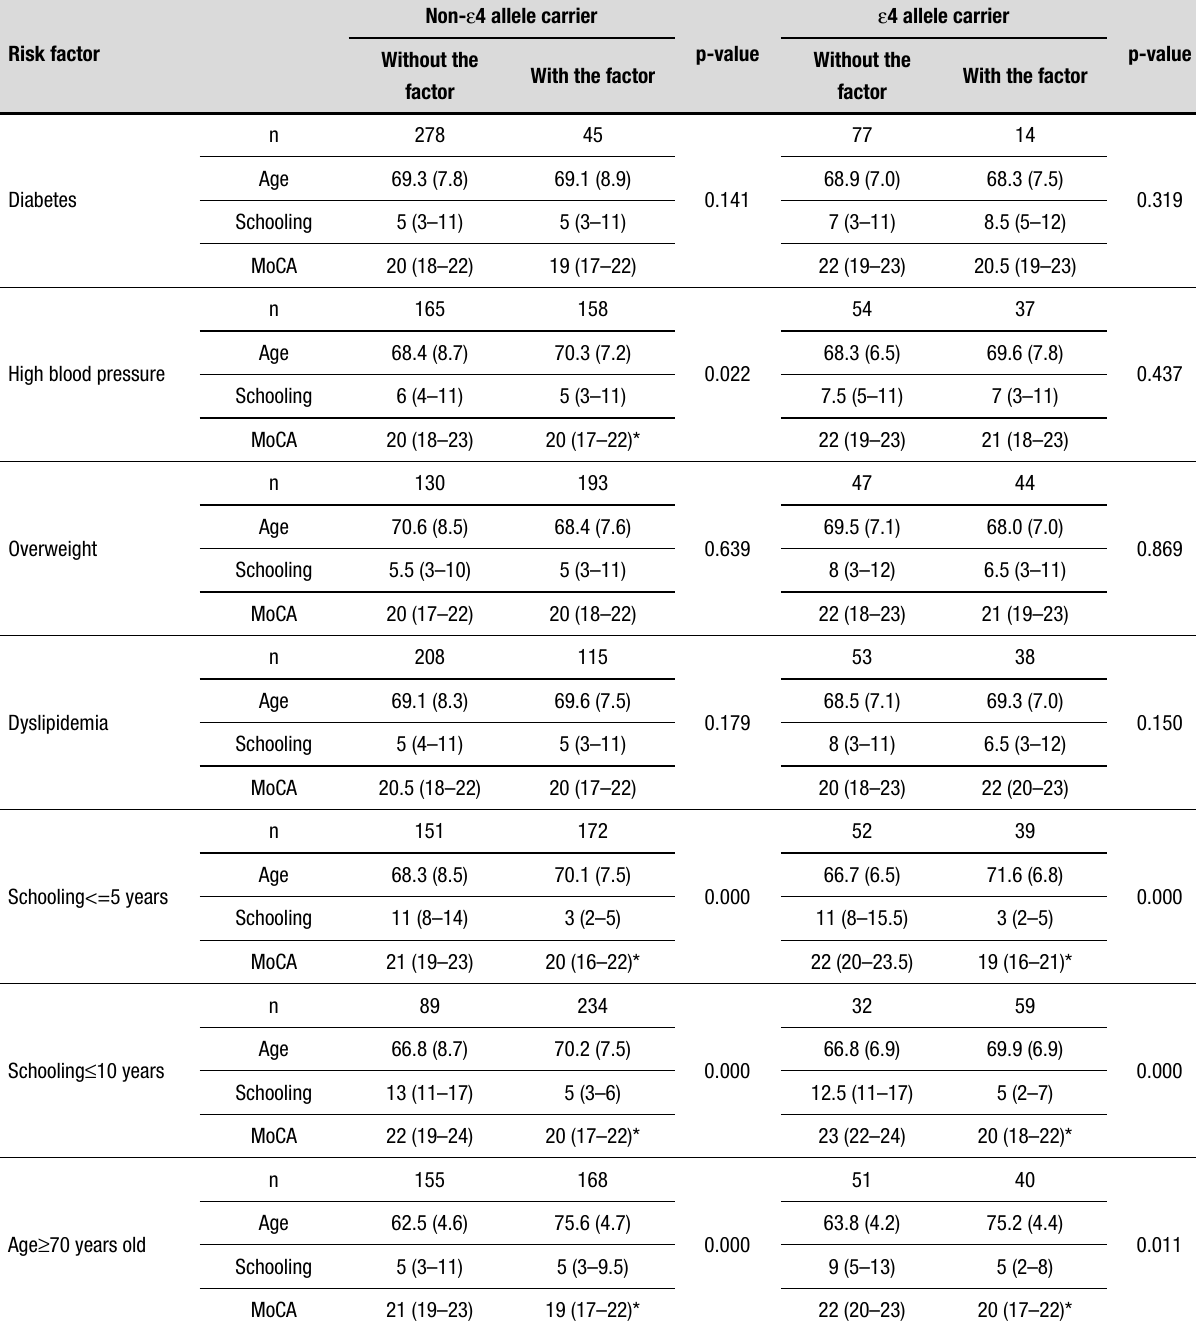
Table 3. Comparison of Montréal Cognitive Assessment Test, by risk factors, between participants with mild cognitive impairment, carriers and non-carriers of the allele ε 4. Non- ε 4 allele carrier Risk factor